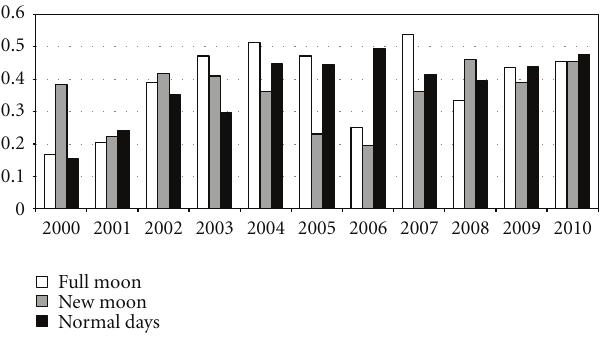
Figure 1: Mean episodes of renal colics per day in relation to lunar phases in 1,500 patients over an 11-year period